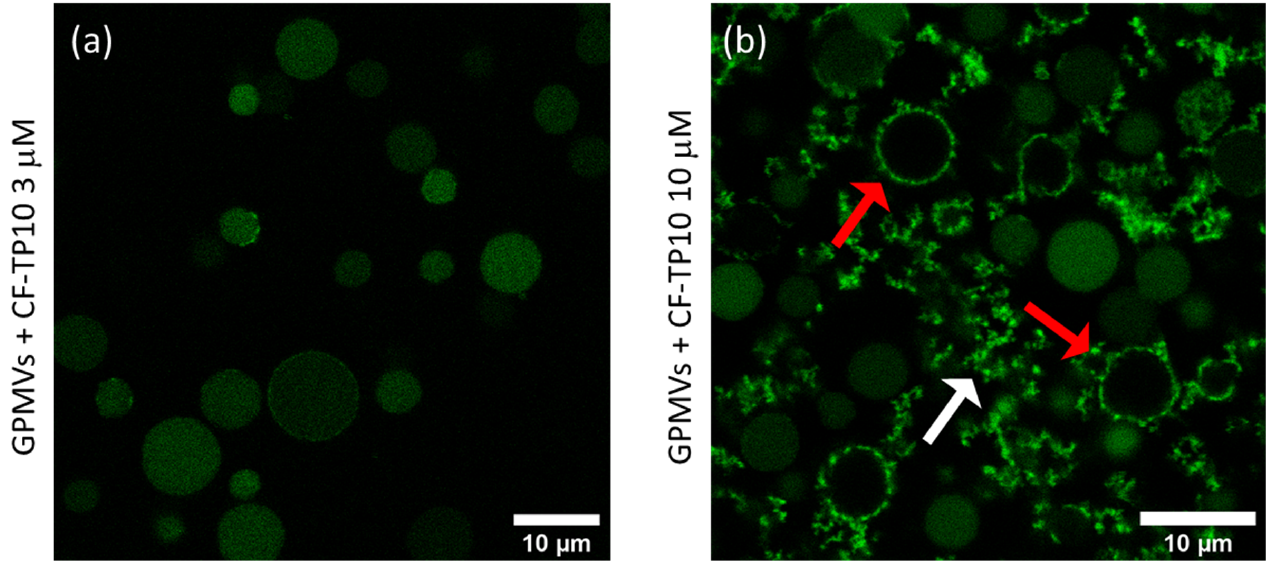
Figure 1. The 1024 × 1024 pixels representative LSCM measurements from GPMVs obtained from HepG2 cells after the addition of ( a ) 3 µ M and ( b ) 10 µ M CF-TP10 ( λ exc = 470 nm; fluorescence range 500–600 nm). Measurements were acquired after 20 h of incubation when the system was in stable conditions. Panel ( a ) reveals that the CF fluorescence is homogenously dispersed inside the GPMVs that retain their spherical shape. This suggests that the peptide translocates the membrane without affecting the morphology of the membrane. In panel ( b ), in addition to intact vesicles, the presence of morphologically modified vesicles is highlighted with red arrows, and the presence of amorphous aggregates, which could be the result of ruptured vesicles, is indicated with a white arrow. Experiments were performed in